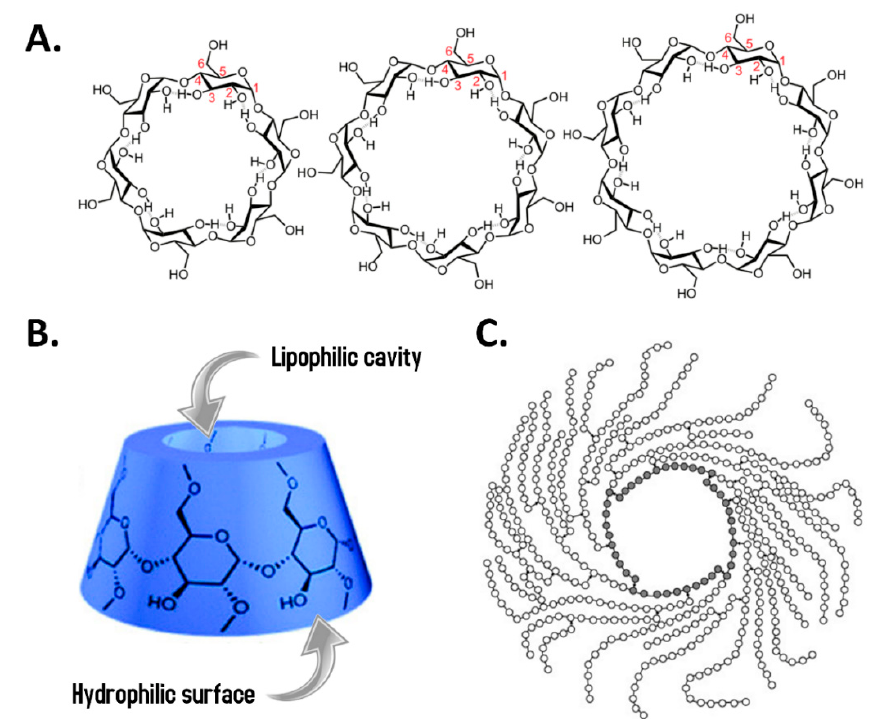
Figure 4. Molecular structures of common cyclodextrins and schematic representation of highly branched cyclic dextrin (HBCD). ( A ). Chemical structure of the α -, β - and γ -cyclodextrins, which contain 6, 7 or 8 glucose units, respectively. Image taken and modified from [86]. ( B ). The conical shape representation of cyclodextrins. These molecules have a truncated cone shape with a hydrophilic external surface (due to the hydroxyl groups on the C2, C3 and C6 atoms) and a hydrophobic cavity (due to the inner hydrogens (H3 and H5) pointing inward) [87]. Cyclodextrins have different water solubility: α - and γ -cyclodextrins have a relatively high solubility (145 and 232 g · L − 1 ), whereas the β -type is much less soluble in water (18.5 g · L − 1 ). Image taken and modified from [88]. ( C ). The schematic representation of HBCD is shown. Open circles represent glucose units while grey-filled circles are those conforming the main centered ring. Lines and arrows are α -(1 → 4) and α -(1 → 6) glycosidic bonds, respectively. Image taken from [89].